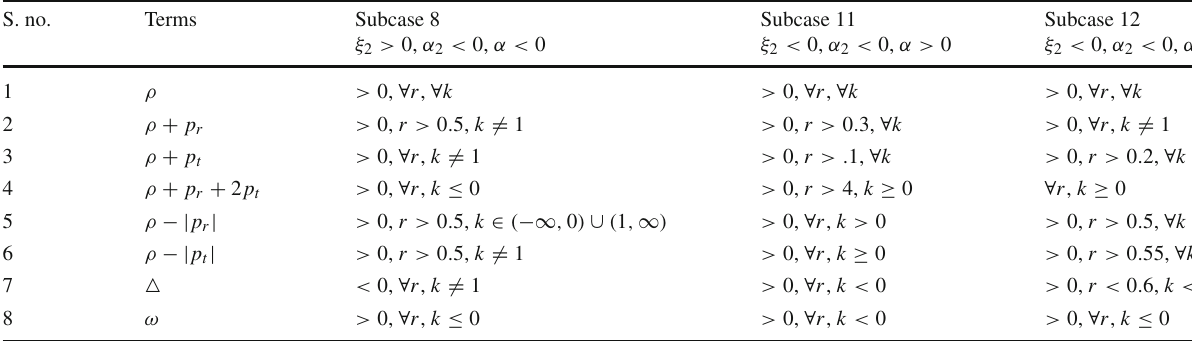
Table 7 Results for Form II: ρ = α 2 Re ξ 2 R S.